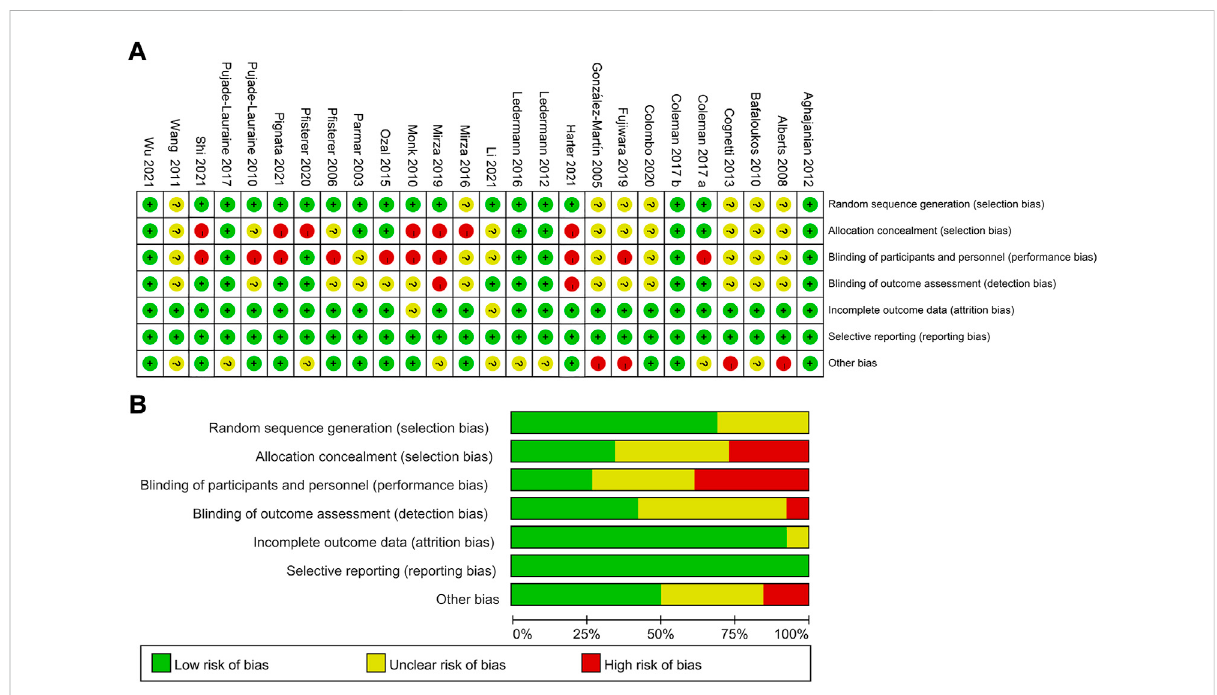
FIGURE 2 RiskassessmentofbiasusingtheCochraneriskofbias. (A) Riskofbiasitemsofallincludedstudiesareindicatedasthepercentages. (B) Eachrisk of bias item for each individual study. Green = low risk of bias, yellow = unclear risk of bias, red = high risk of